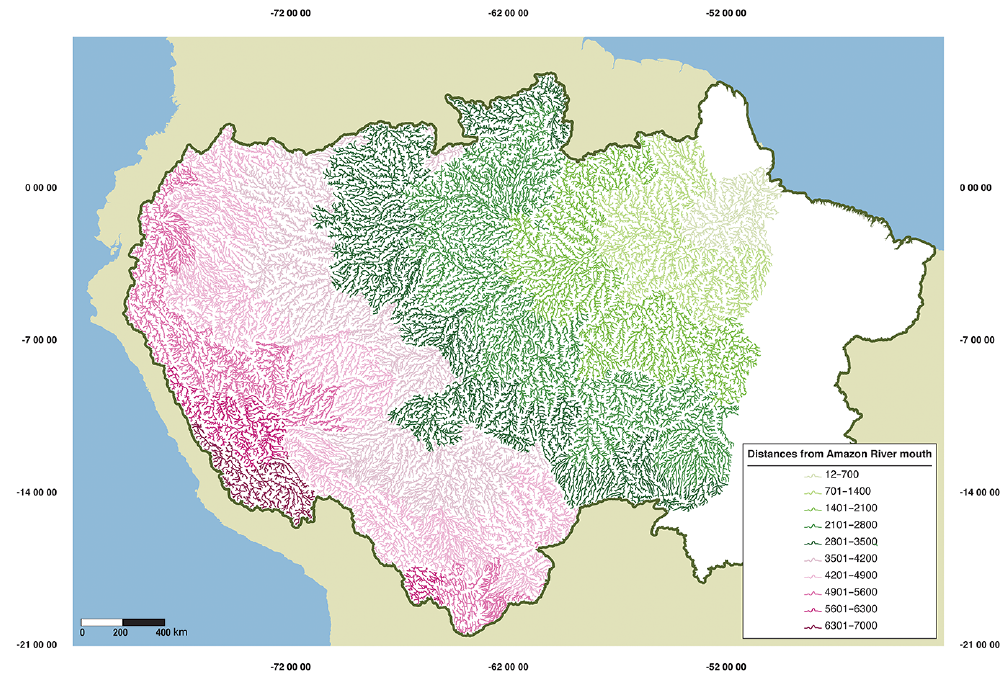
Figure 6. Cartographic representation of river distances from Amazon River